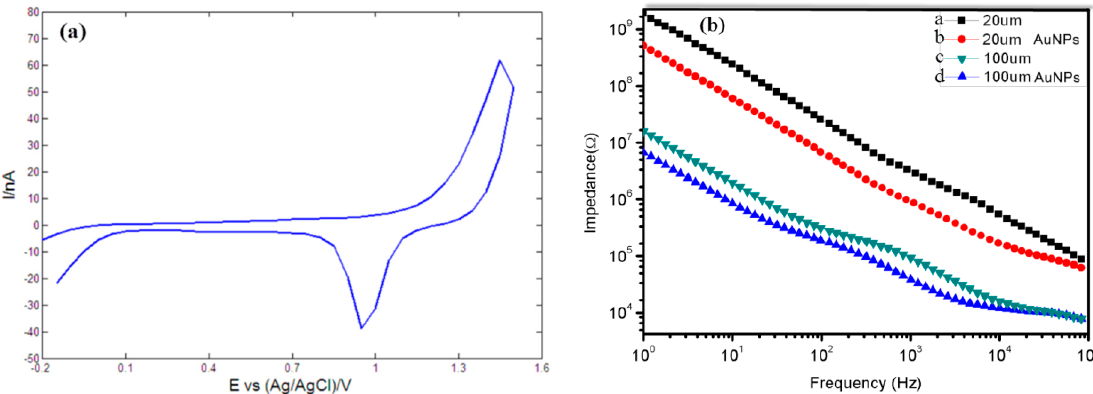
Figure 11. ( a ) Representative cyclic voltammogram of a recording site immersed in 0.5 M H 2 SO 4 ; ( b ) impedances of a recording site (curve a, b) and a stimulating site (curve c, d).